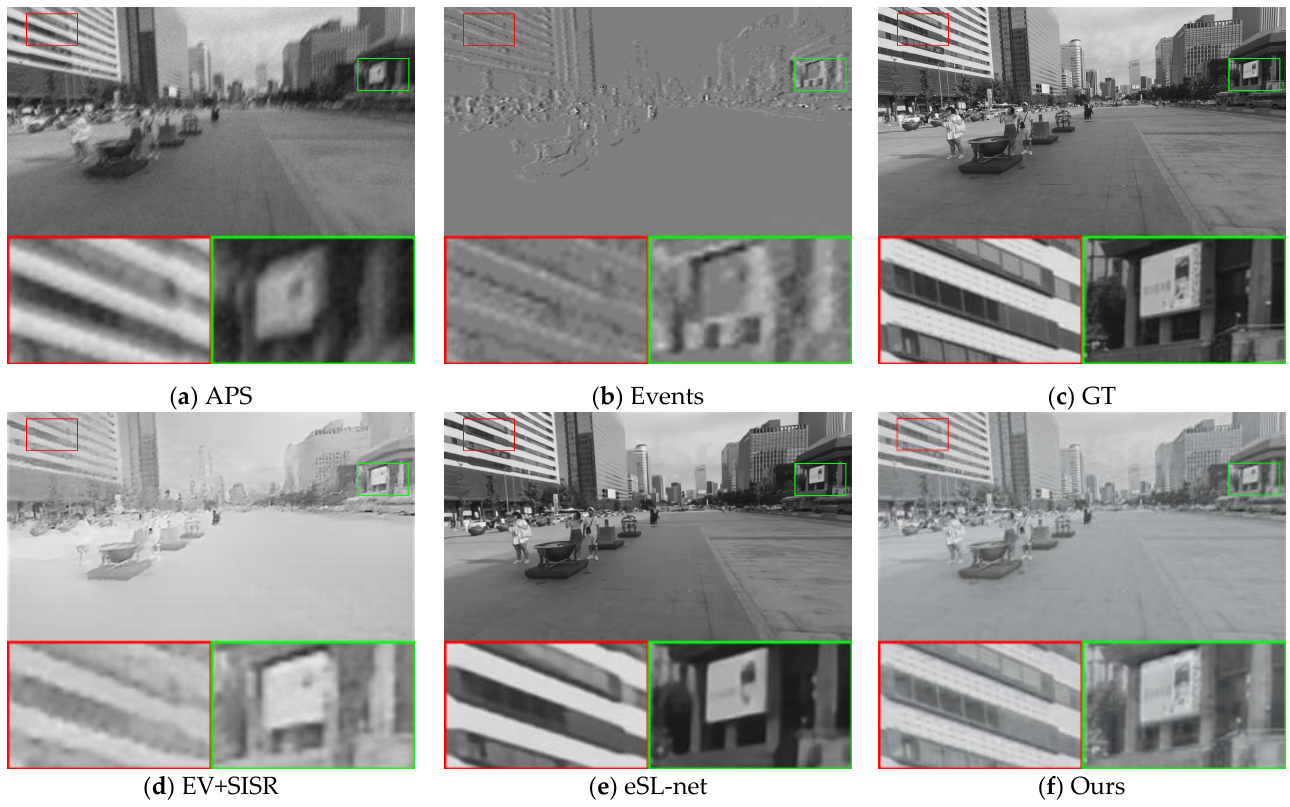
Figure 5. Comparison of the visual quality of our proposed method with other state-of-the-art meth- ods for 4× SR on synthetic datasets. The APS frame and event stack are upsampled with bicubic interpolation to the corresponding scale for reference.